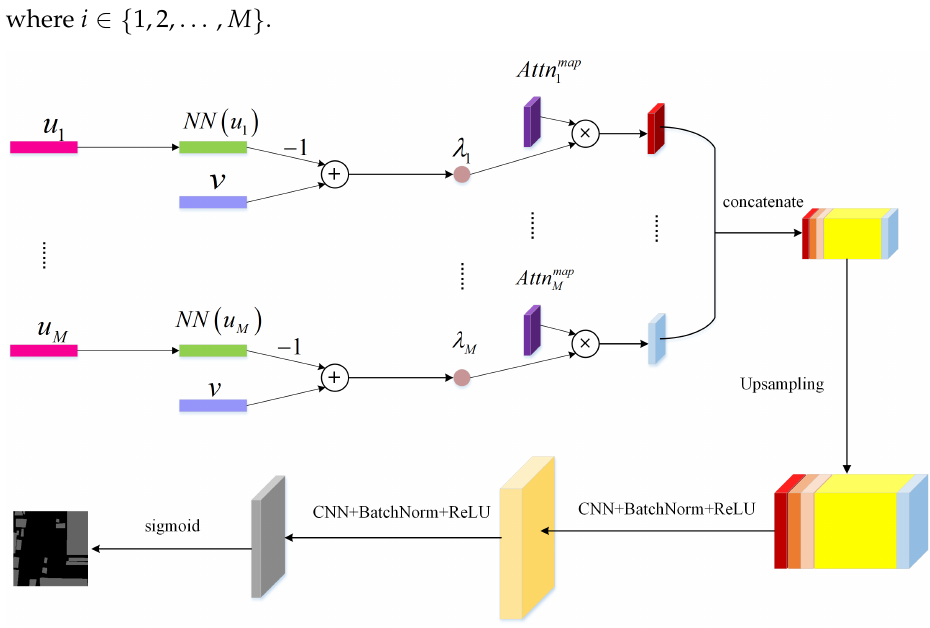
Figure 3. The architecture of our